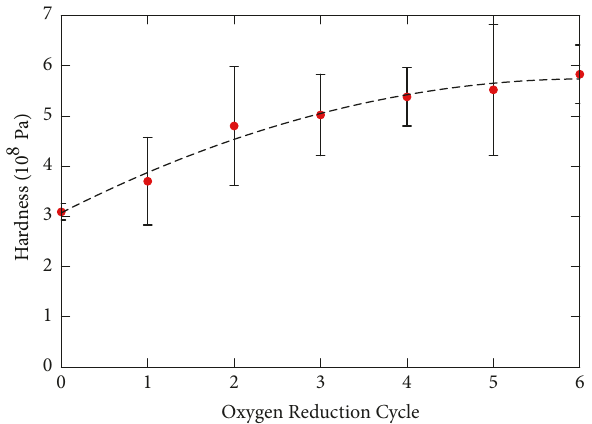
Figure 17: This plot compares the hardness of the sample based on the number of LightScribe reduction cycles. The red points are the average values for the thirty data points taken after each cycle. In order to depict the changing nature of the hardness, these points were fit using a polynomial function shown above. The hardness increasedforthethreereductioncyclesbeforelevelingoffduringthe fourth and fifth cycles. The error bars depict the standard deviation of the hardness for the thirty data points taken after each reduction cycle.